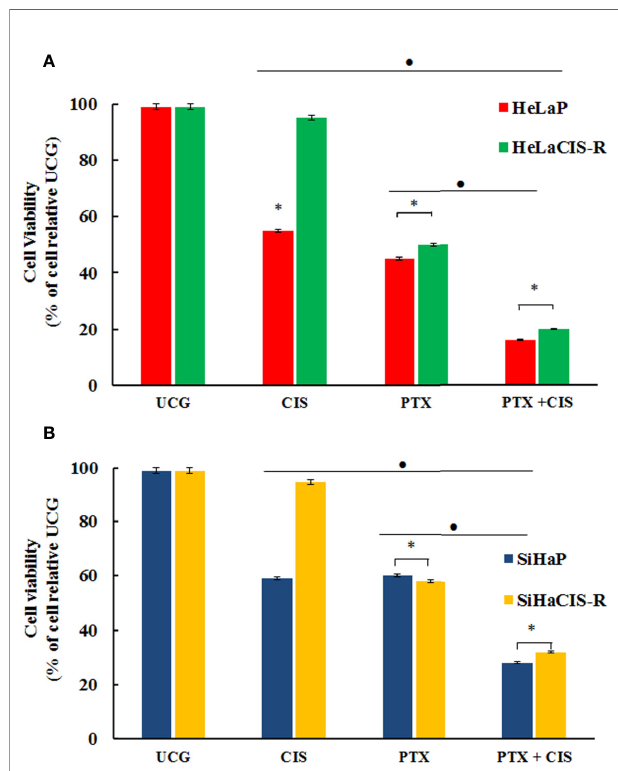
FIGURE 1 | PTX decreases viability and induced sensitization to CIS treatment in resistant cervical cancer cell lines. Cell viability was assessed using the WST-1 assay (A) . HeLaP and HeLaCIS-R cell lines were treated with CIS (20 m M), PTX (4 mM), or PTX + CIS (4 mM + 20 m M) for 24 h (B) . SiHaP and SiHaCIS-R cells were treated with CIS (30 m M), PTX (4 mM), or PTX + CIS (4 mM + 30 m M) for 24 h. Data are expressed as the percentage of cells relative to the UCG. * p < 0.01 = statistical signi fi cance after comparison among the PTX, or CIS, or PTX + CIS groups in HeLaCIS-R cells or SiHaCIS-R vs. parental cells. ● p < 0.01 PTX + CIS vs. PTX group or CIS group in parental or resistant cells. UCG, Untreated Control Group; CIS, Cisplatin; PTX,